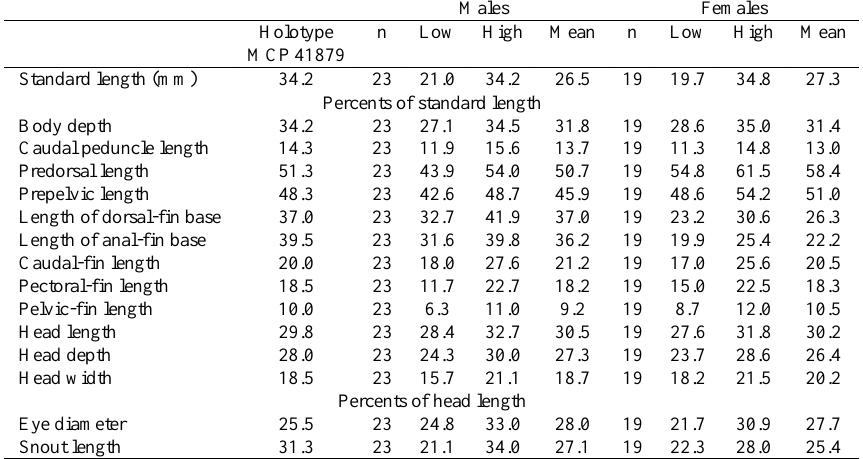
Fig. 3. Austrolebias paucisquama , paratype, MCP 41880, female 32.6 mm SL, Rio Grande do Sul, São Sepé, temporary pool close to BR290 highway (30°22’27”S 53°33’42”W), rio Vacacaí color light brownish, sides of body with a variable number of relatively large dark black spots distributed mostly on poste- rior portion of body – distinguish A. paucisquama from all other species of the genus. Description. Morphometric data on Table 1. Largest male 34.2 mm SL; largest female 34.8 mm SL. Body compressed. Dorsal head profile slightly concave, more evident in females. Dor- sal profile convex from nape to insertion of last dorsal-fin ray. pectoral fin in males and the color pattern of females – ground Table 1. Morphometric data of Austrolebias paucisquama . Ranges presented for males include the holotype. n = number of specimens.